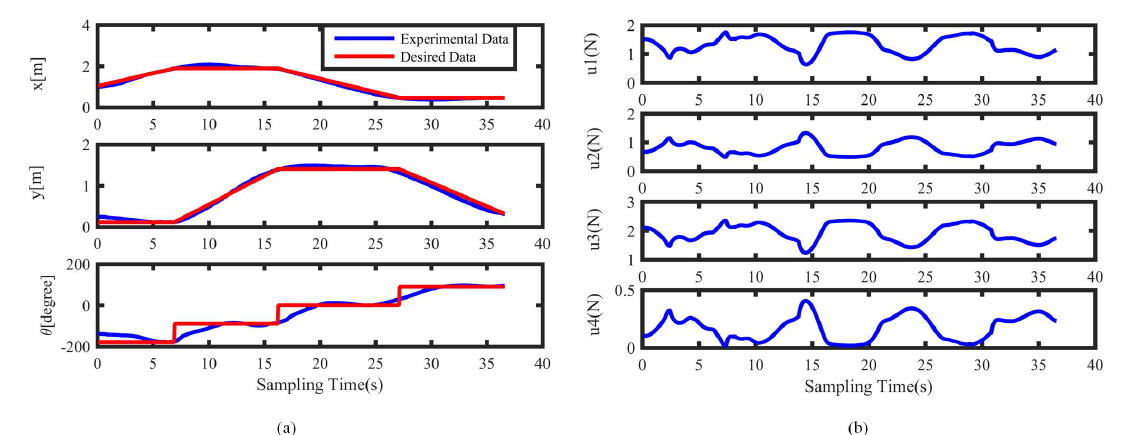
Figure 23. The tracking result of the robot in square tracking. ( a ) States of the robot at different times. ( b ) Thrusts varying of the four